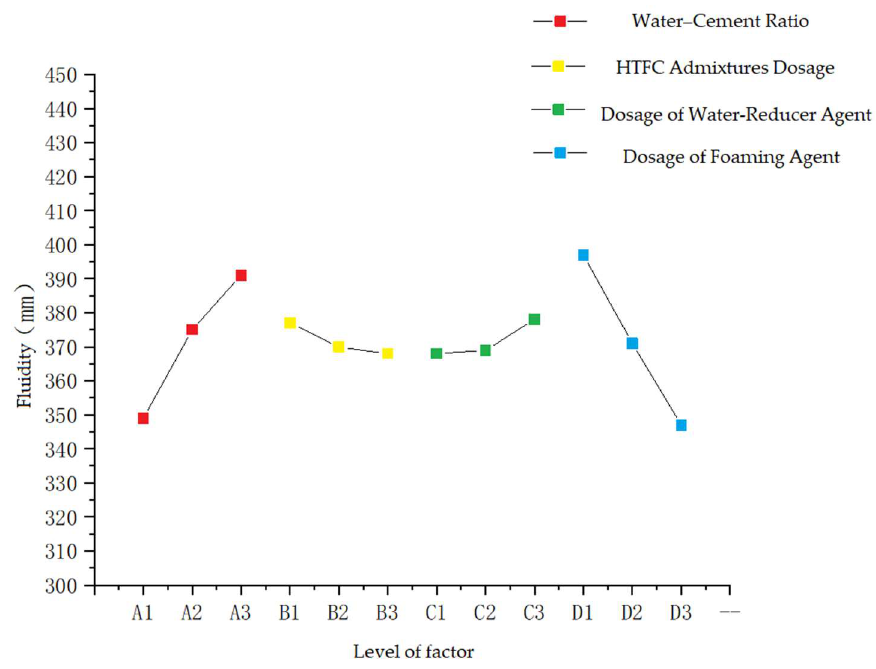
Figure 5. Relationship between factors and